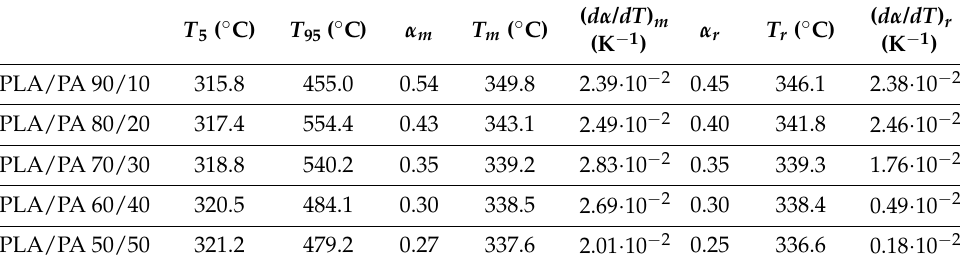
Table 2. Decomposition temperatures of the PLA/PA bioblends, at a nominal heating rate of 10